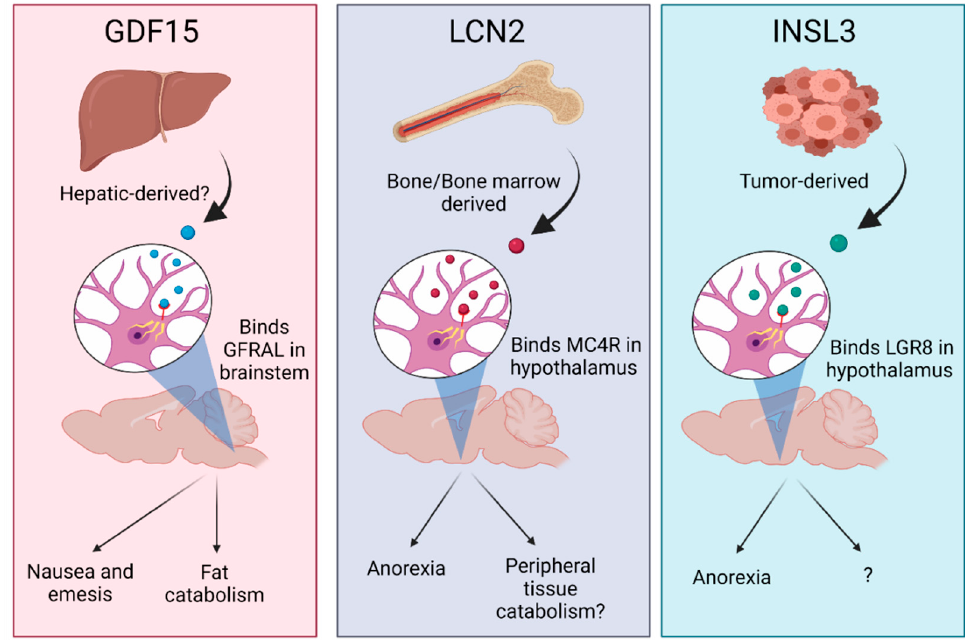
Figure 4. Graphical representation of cachexia-inducing effects of GDF15, LCN2 and INSL3 after binding to their respective receptors in the brain.